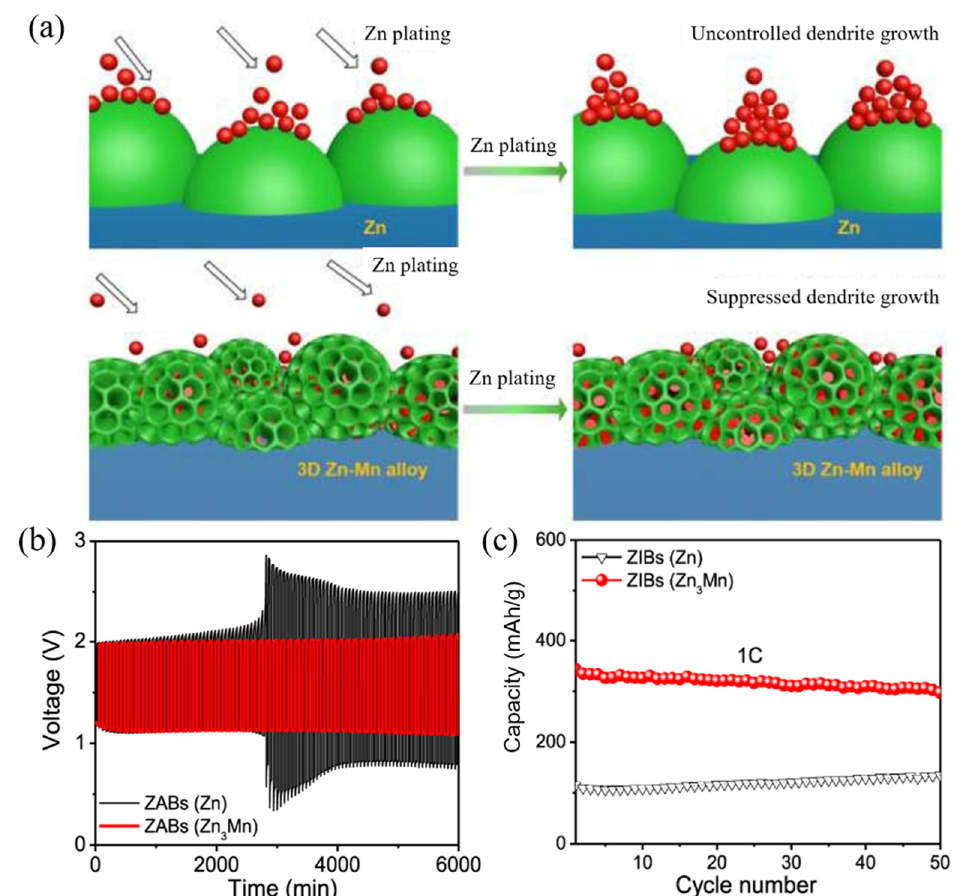
Figure 7. ( a ) Schematic representation of the zinc deposition process on pure zinc anode and Zn 3 Mn alloy anode. ( b ) Cycling performance of zinc–air batteries with Zn 3 Mn alloy and Zn anode. ( c ) Cycling performance of zinc-ion battery (Zn 3 Mn and Zn) at 1C using seawater-based electrolyte [31]. Reprinted with permission from Ref. [31], Copyright 2021, Springer Nature.